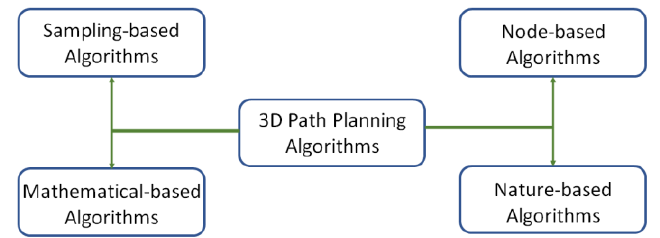
Figure 1. 3D path planning algorithms taxonomy [5,47].